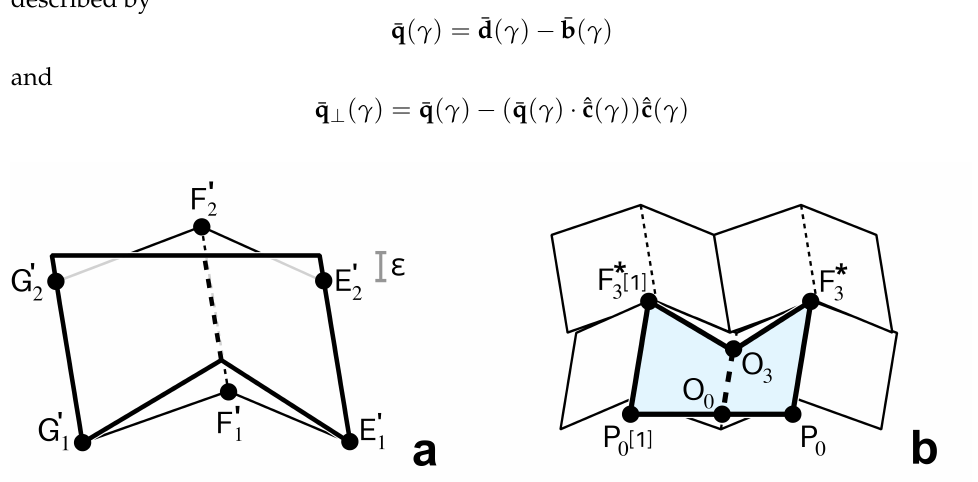
Figure 5. ( a ) Placing S 1 on C 4 . ( b ) Attaching S 1 to asymmetric zipper-coupled tubes.